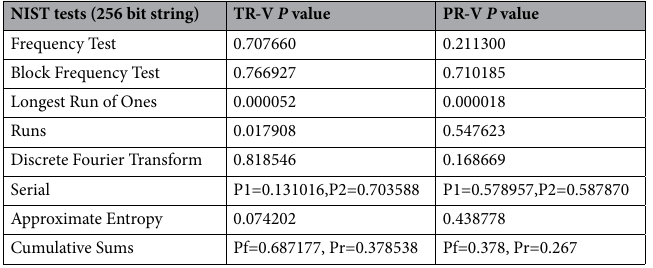
Table 9. NIST tests’ results for 256 bit